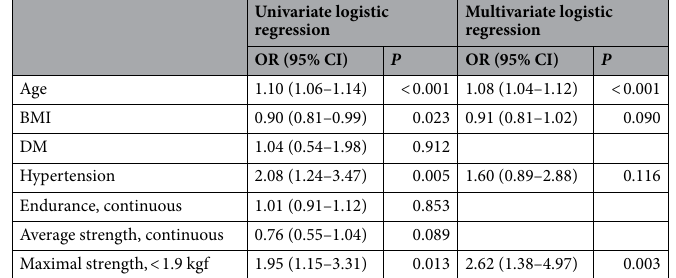
Table 2. Logistic regression analysis for an International Index of Erectile Function-5 score ≤ 12. OR odds ratio, BMI body mass index, kgf kilogram-force.